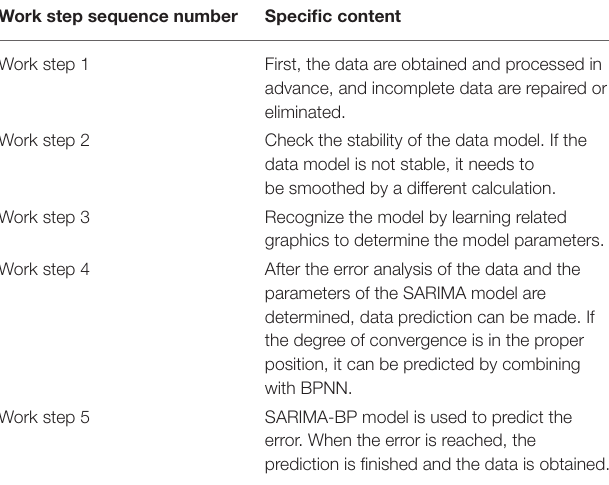
TABLE 1 | Work steps and